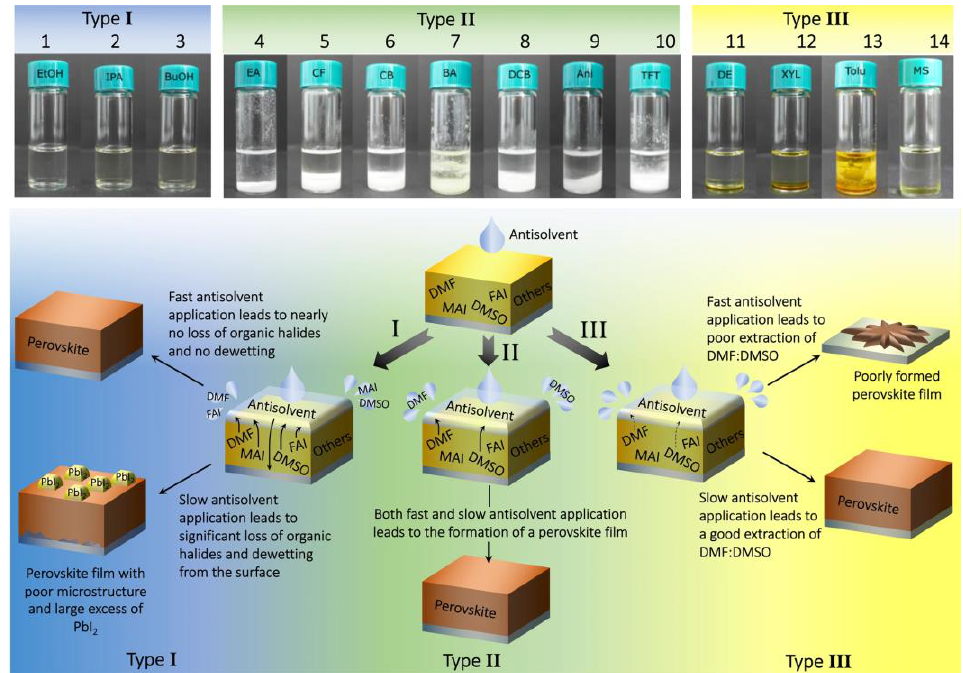
Figure 3. Summary of the processes taking place during perovskite film formation for the three antisolvent types. Top: solubility of MAI in a solution of DMF:DMSO:antisolvent, meant to simulate the perovskite film intermediate phase during the antisolvent step of fabrication. Bottom: summary of the various mechanisms involved in perovskite film formation by the different categories of antisolvents. [154].